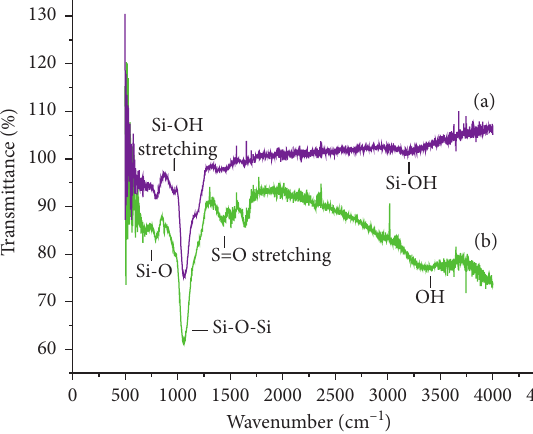
Figure 2: FTIR spectra of (a) silica gel and (b) Si-H +